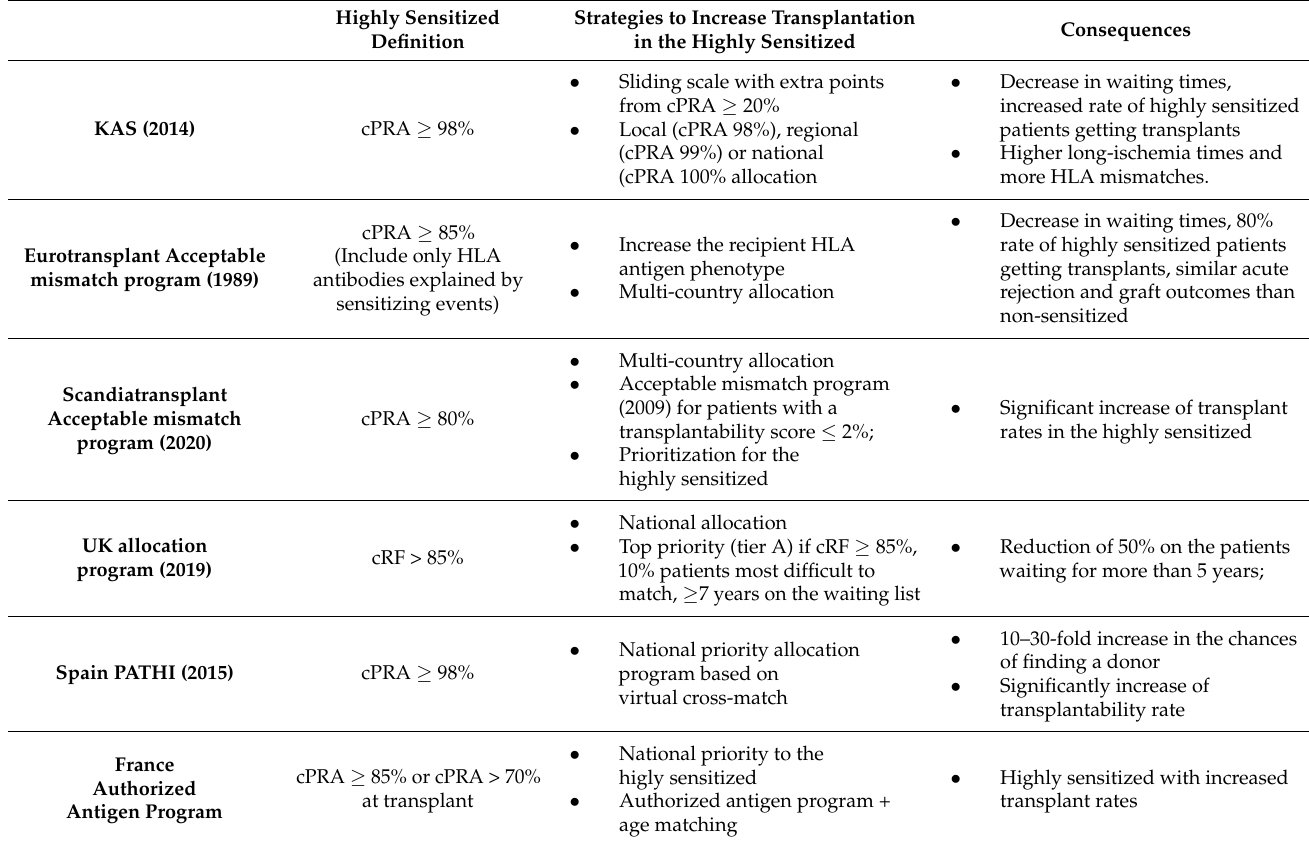
Table 1. Special allocation programs for the highly